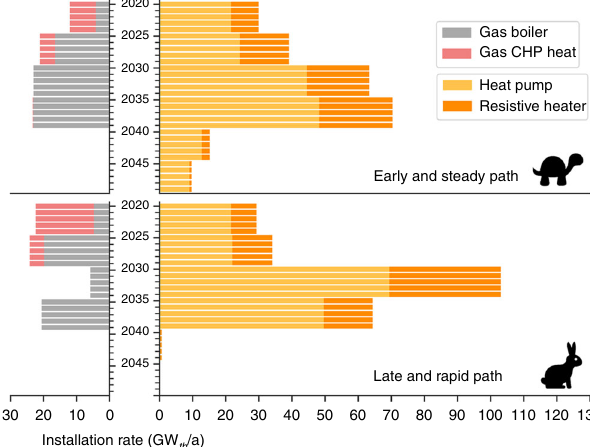
Fig. 4 Required expansion of heating capacities in both paths. Maximum heating capacities are shown for CHP plants.